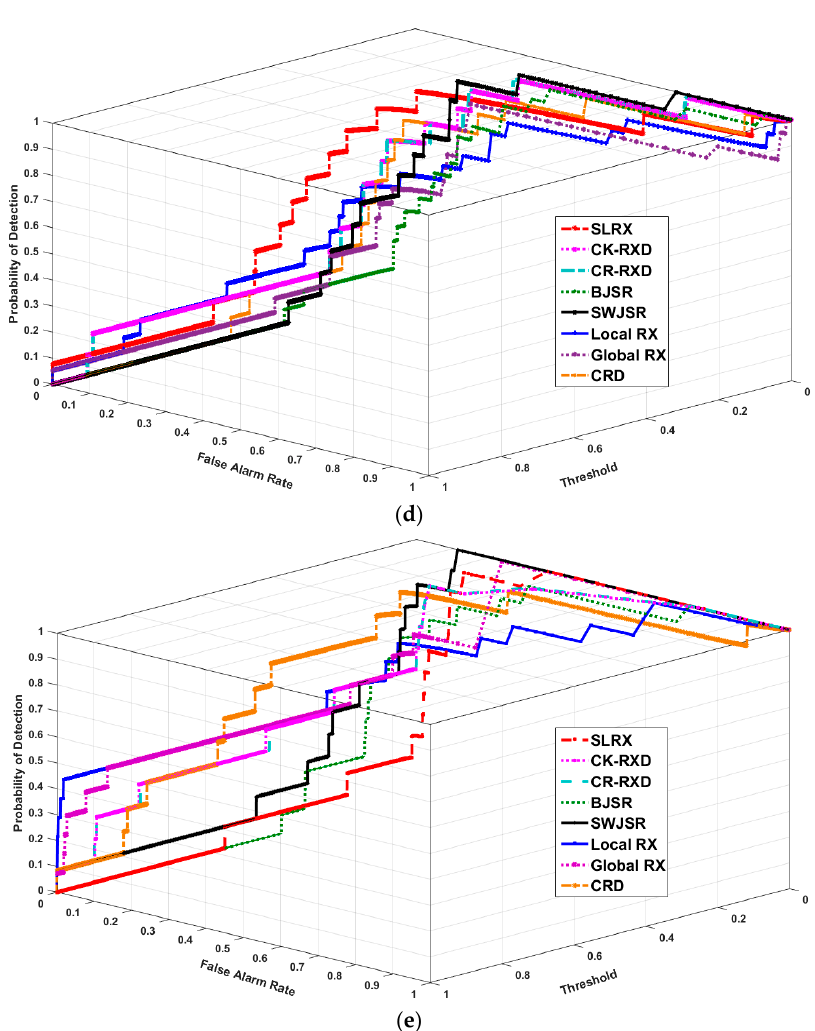
Figure 8. 3D ROC curves of the anomaly detection algorithms: ( a ) Real RIT dataset; ( b ) Real San Diego dataset; ( c ) Real Viareggio dataset; ( d ) Implanted RIT dataset; and, ( e ) Destructed RIT dataset. Remote Sens. 2018 , 10 , x FOR PEER REVIEW